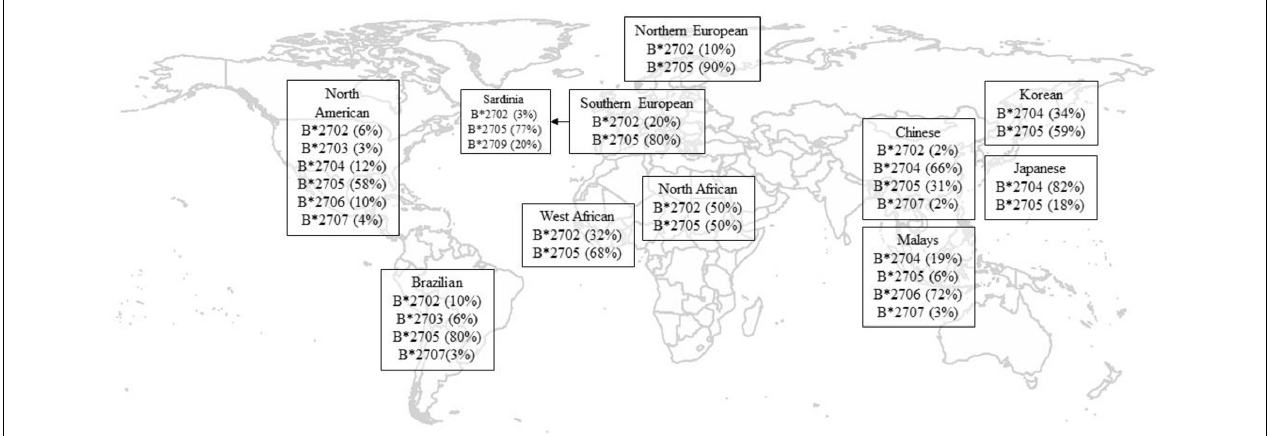
FIGURE 1 | Geographical distribution of HLA-B27 subtypes. Only the most frequent alleles were shown, and statistics are rounded off for simplicity and indicate percentage in healthy controls. Data of North American were adapted from Gragert et al. (2013; Supplementary Table 1 ). Data for Korean were adapted from Park et al. (2009). Data of other populations were adapted from Khan et al.